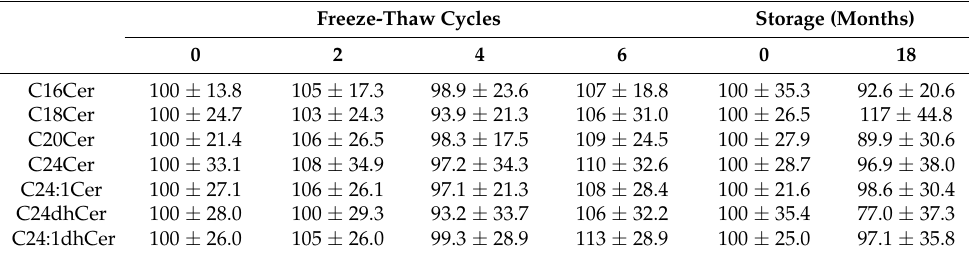
Table 7. Effect of storage conditions on relative sphingolipid levels in human blood